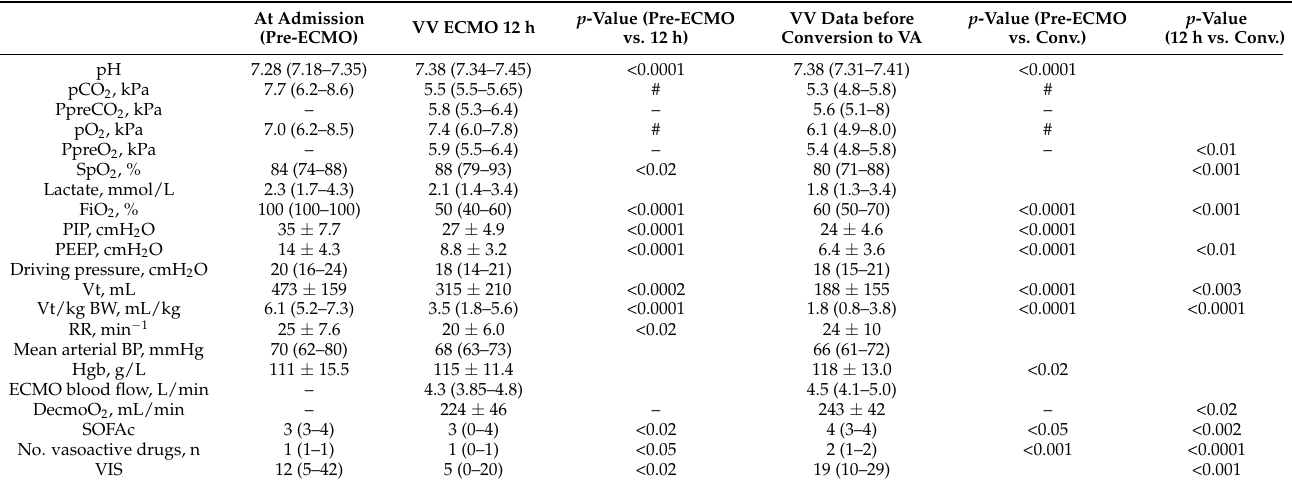
Table 2. Patients converted from venovenous to venoarterial extracorporeal membrane oxygenation. Respiratory and circulatory data at admisson, after 12 h of venovenous extarcorporeal membrane oxygenation (ECMO) support, and at the time of conversion to venoarterial support. # Six patients (13%) had arterial blood gases available 12 h after ECMO initiation, and 14 patients (30%) had arterial blood gases available in the last 4 h before conversion to VA ECMO. Clinical monitoring was made from pre-oxygenator blood gas assessments not presented in this table. Abbreviations: FiO2: fraction inspired oxygen; PIP: peak inspiratory pressure; PEEP: positive end-expiratory pressure; Vt: tidal volume, BW: body weight;